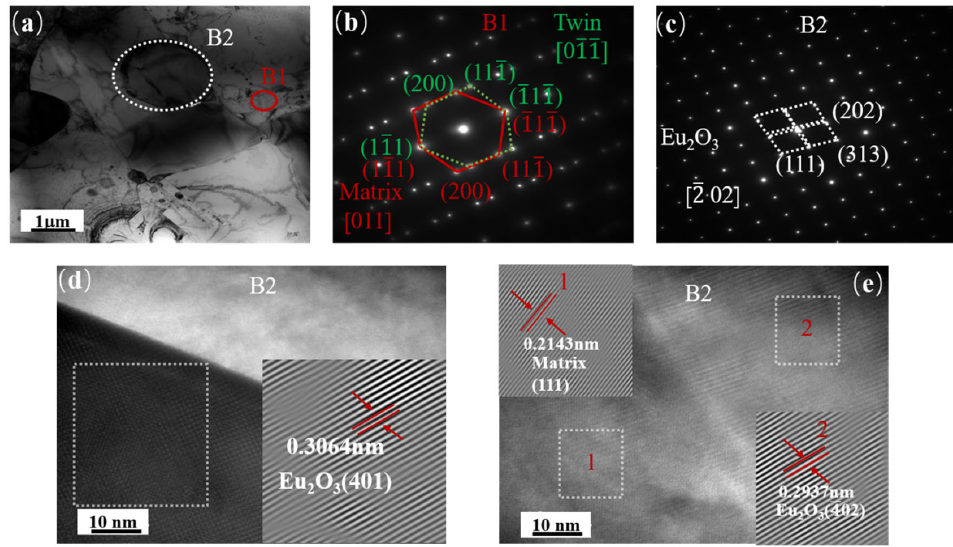
Figure 10. TEM bright field images of the HP20 composite: ( a ) A bright TEM image; ( b ) the corre- sponding SAED patterns of twin; ( c ) the corresponding SAED patterns of Eu 2 O 3 ; ( d ) obtained from the regions marked in B2 in ( a ); ( e ) obtained from the regions marked in 1 and 2 in ( d ).